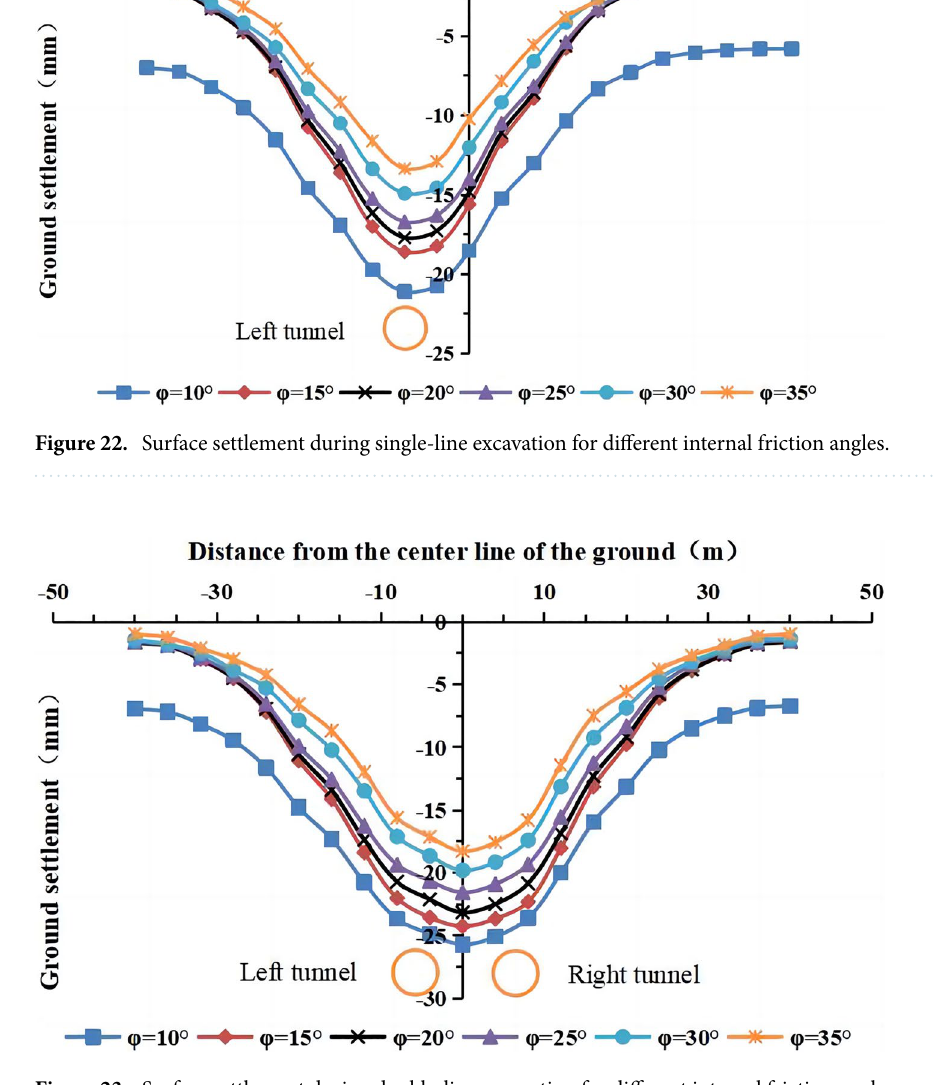
Figure 23. Surface settlement during double-line excavation for different internal friction